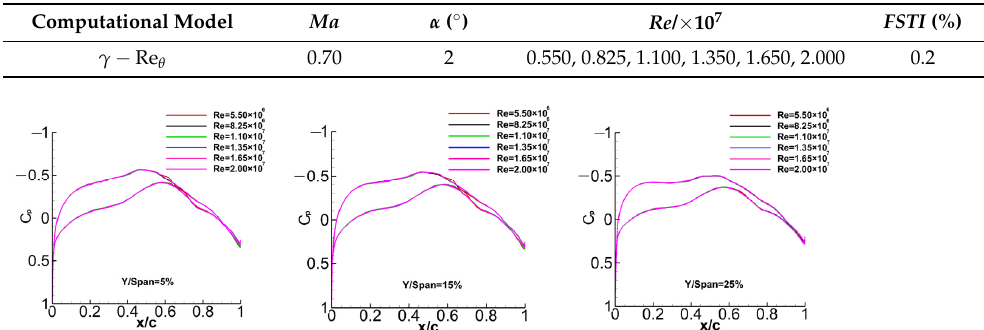
Table 4. Calculated states and method for different Re .